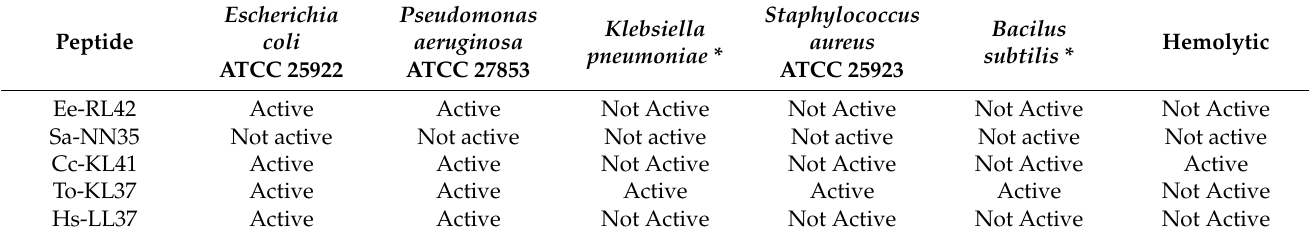
Table 5. Bioinformatic prediction of the biological activity against specific microorganisms. The Bioinformatic tool (database of antimicrobial activity and structure of peptides, DBAASP) predicted the susceptibility of microorganisms and human erythrocytes to the putative peptides from the Eulipotyphla order, including Talpa occidentalis , and using human cathelicidin Hs-LL37 as a reference.